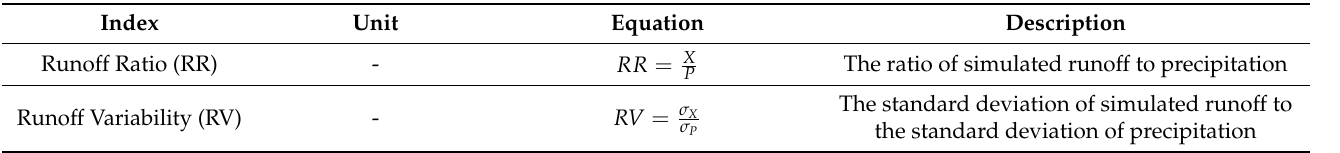
Table 2. Hydroclimatic indices used for the sensitivity analysis